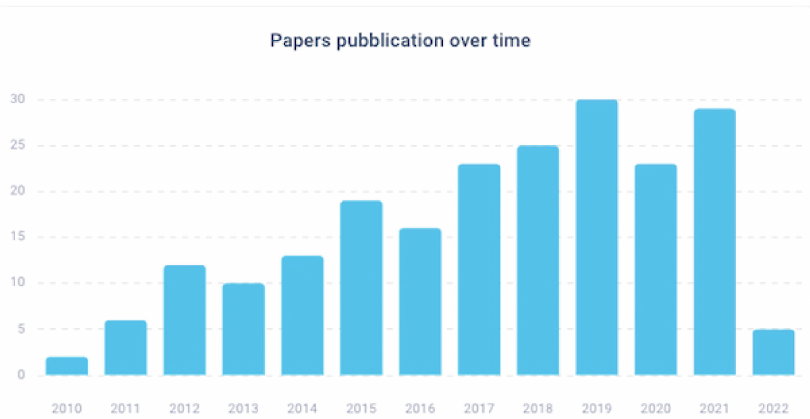
Figure 2. Published articles by year.